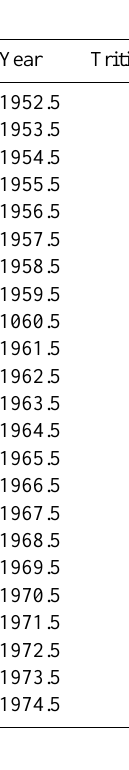
Table A1. Surface-water tritium values 1952–1974. Time is given in fraction of a full year, i.e., 1952.5 is mid-1952. These are the original Dreisigacker and Roether (1978) data, for calibration to the northwestern Levantine Sea, the values have to be multiplied by 1.61.